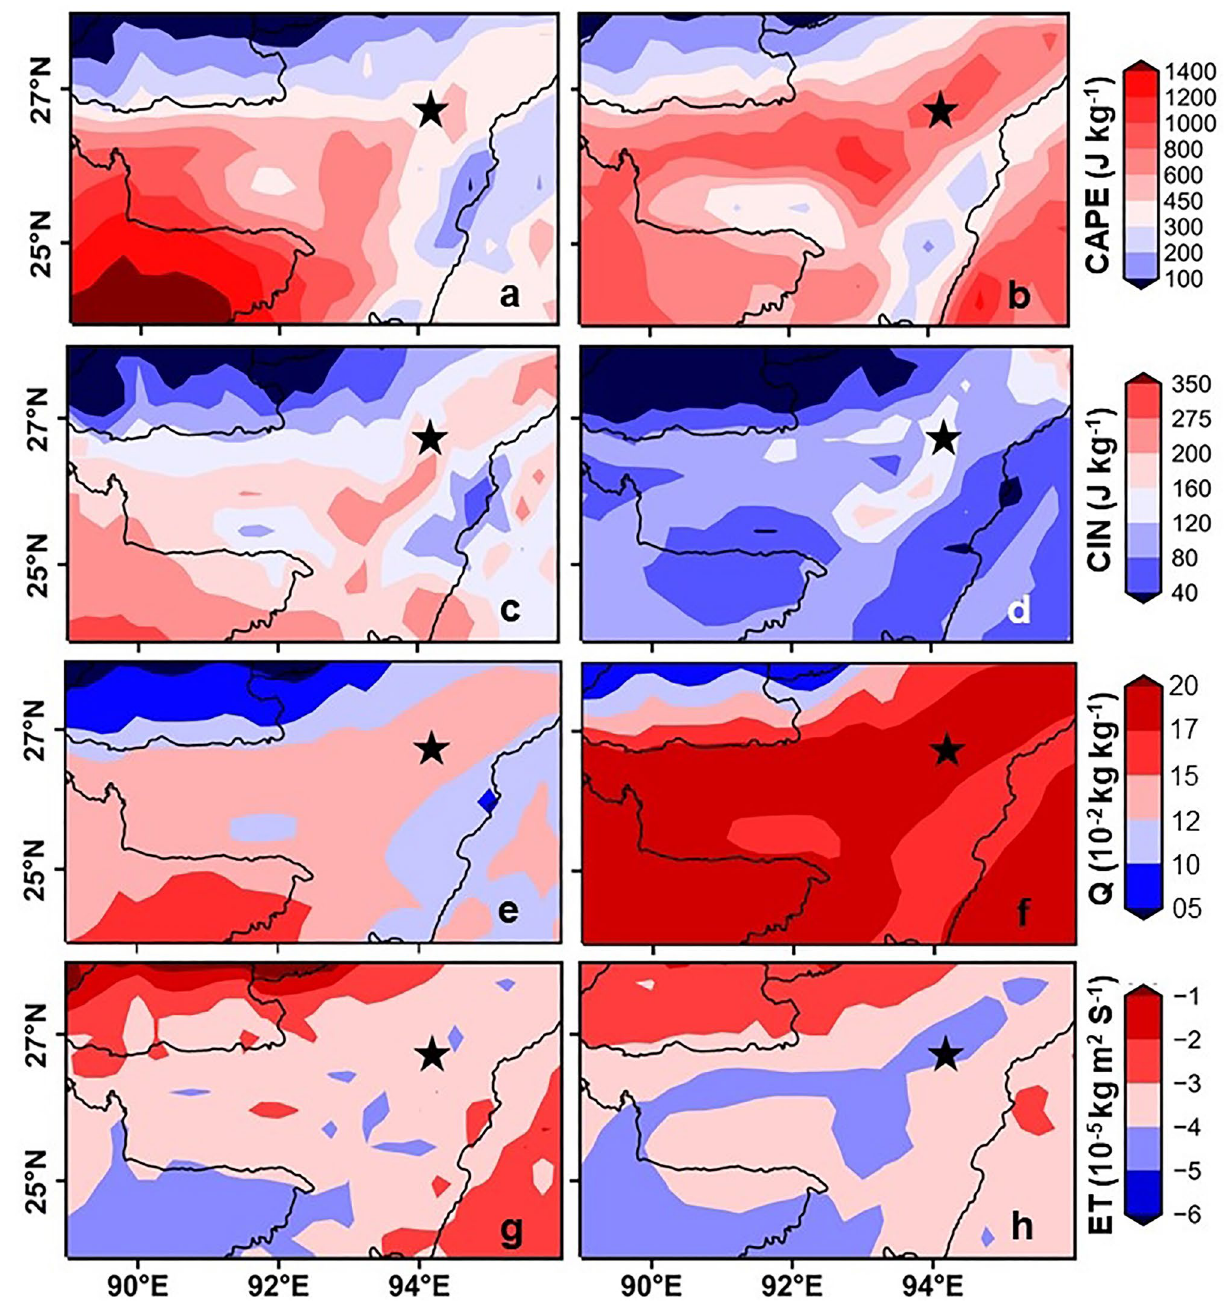
Figure 2. Meteorological evidence of localised moisture recycling. ( a , c , e , g ) The seasonal climatology of CAPE, CIN, Q and ET during Pre-monsoon (Mar–May) computed for the period 1979–2018 with the help of ERA 5 reanalysis dataset. ( b , d , f , h ) Similar plot but for the period of the ISM season evaporation decreases the d-excess of residual soil moisture 15,31–33 . This high d-excess can only be explained if the source d-excess values are significantly high. We hypothesise that the flooding in Brahmaputra [major source of high d-excess (~ 12.8‰)] during the previous years’ ISM period, recharges the surface as well as subsurface water, which in turn is transpired by the plants 5,13 . Our hypothesis is further substantiated by similar d-excess values in precipitation and river water (Fig. 2b) and higher localized recycling (~ 53%), estimated with the help of a simple empirical model based on HYSPLIT backward wind trajectories (Fig. 4a). In the HYSPLIT simulations, we have identified four major sources for the origin of vapour- Bay of Bengal, Arabian Sea, Local recycling, and continental which refers to the rest of recycled moisture but not of local origin (refer Section "Hysplit clustered trajectories" for more details). The increasing trend in monthly estimated localized recycling (inset; bottom right Fig. 4 a) concurs with the increasing trend of evapo-transpiration given by Chakraborty et al. 8 .